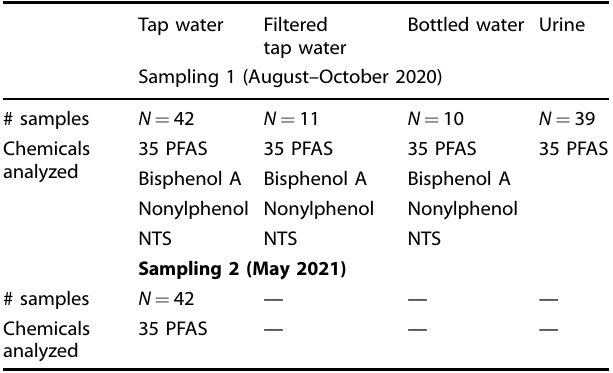
water (Table 4). Samples were collected in 500 mL polypropylene bottles for PFAS analysis. The shipment and storage procedures were identical to the fi rst sampling.